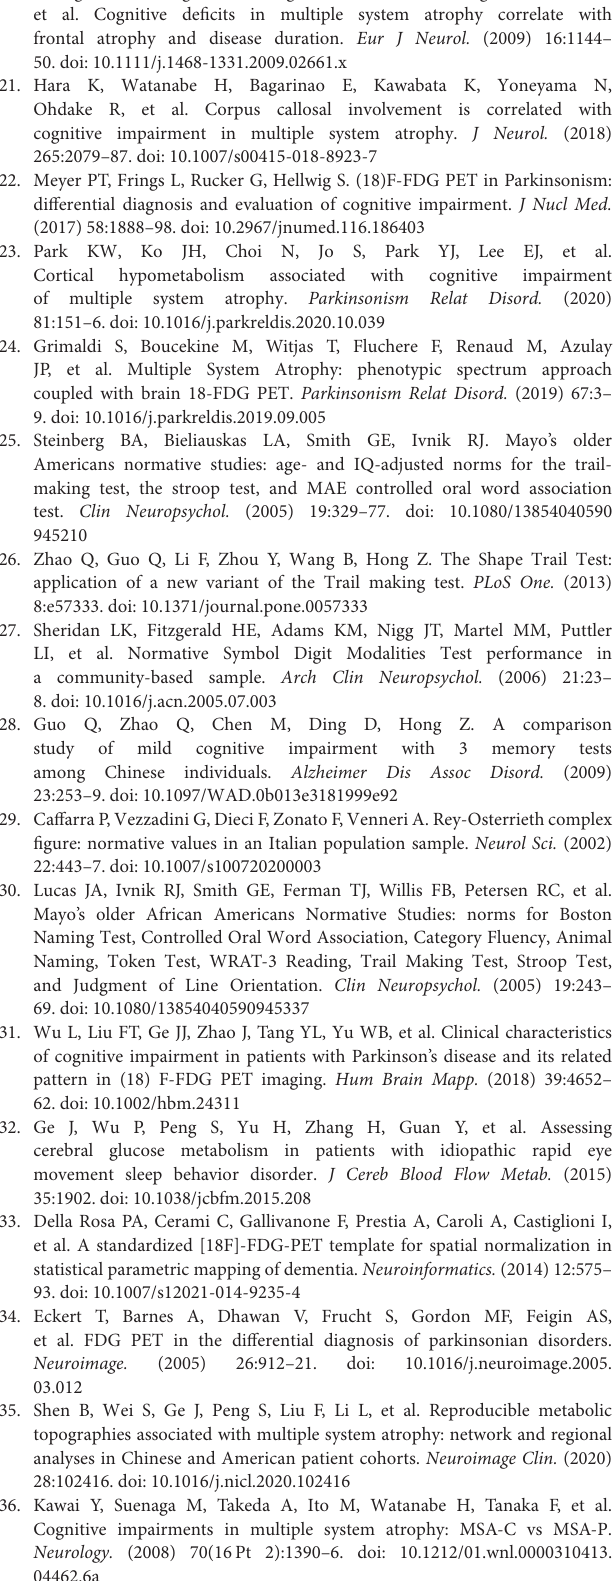
figure: normative values in an Italian population sample. Neurol Sci. (2002) 22:443–7. doi: